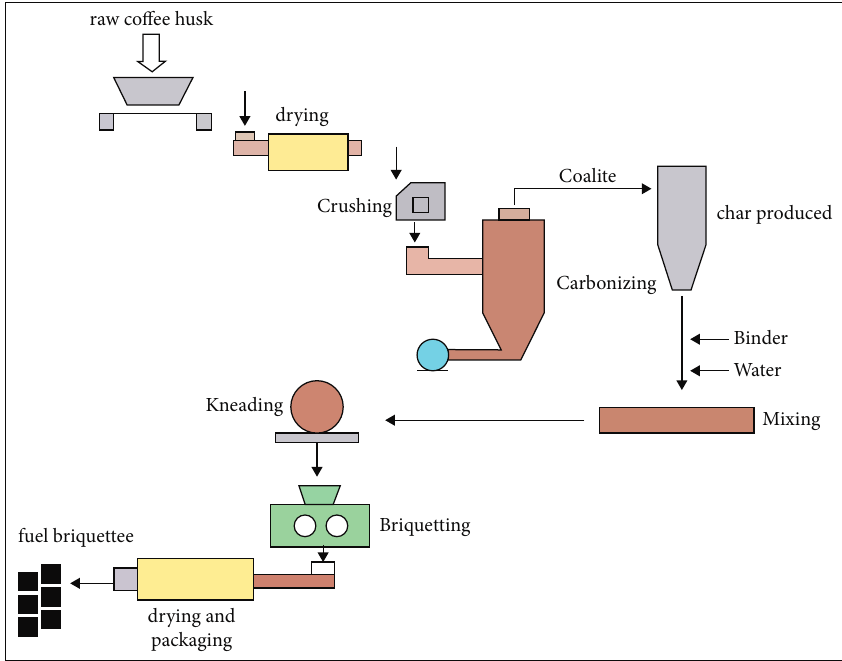
Figure 2: Process flow of briquette Table 1: Proximate analysis of fuel briquettes [7, 24, 26, 29, 41, 43].